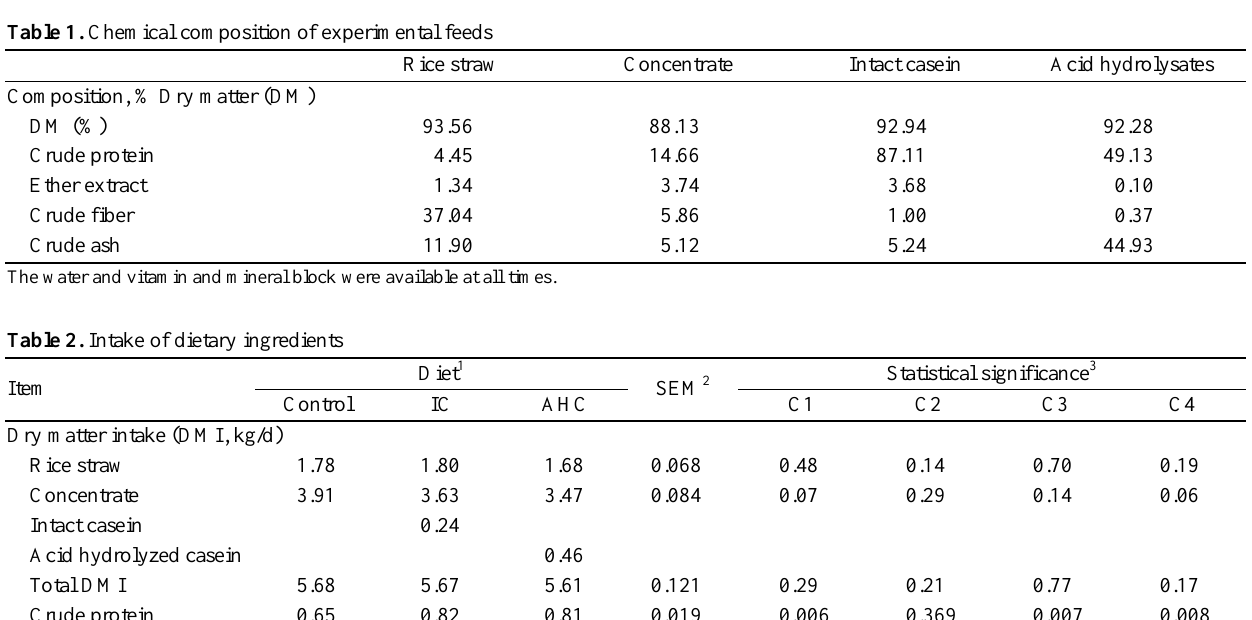
Rice straw Concentrate